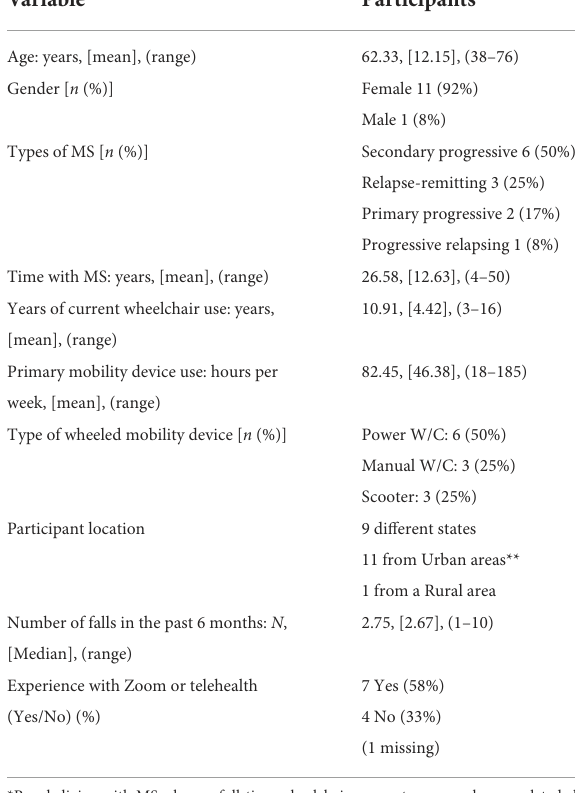
TABLE 3 Characteristics of the iROLL